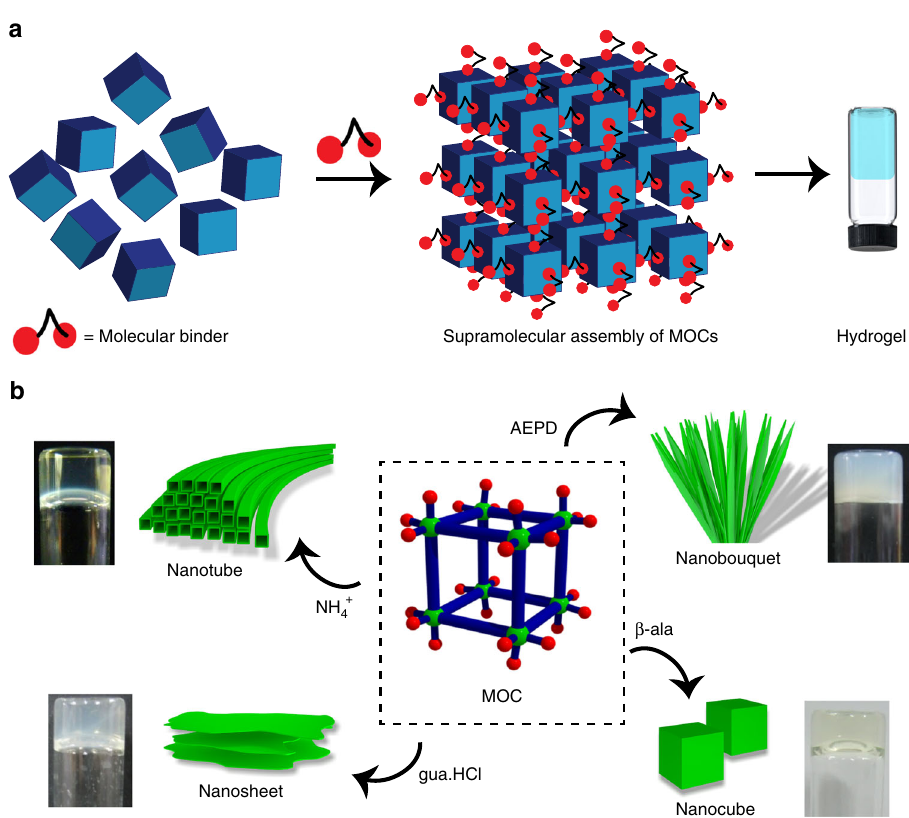
Fig. 1 Molecular binder-driven self-assembly of MOC to hydrogels. a Schematic representation of CAHB driven self-assembly of MOC with small molecular binders towards the formation of hydrogel. b Self-assembly of MOC with different molecular binders (NH 4 + cation, AEPD, gua.HCl and β -ala) results in hydrogels with nanotube, nanobouquet, nanosheet and nanocube morphologies,